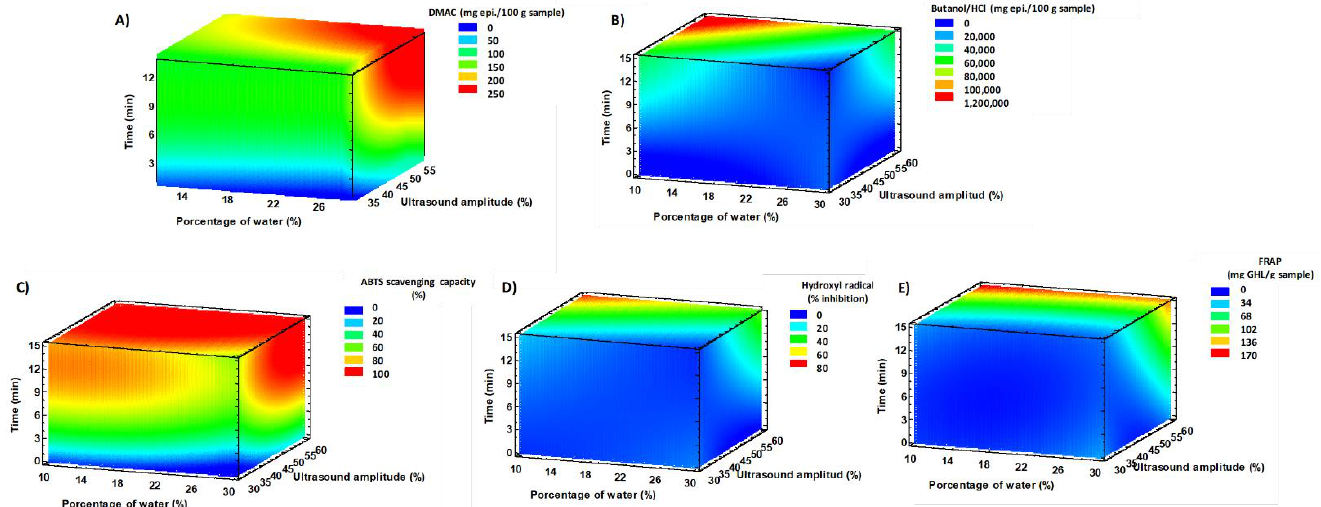
Figure 2. 3-D contour plots showing the effects of the extraction time (min), the ultrasound amplitude (%), and the percentage of water (%) in the NaDES (ChCl:LA, 1:2) on the total PA content (DMAC ( A ) and butanol/HCl ( B ) assays) and total antioxidant capacity (ABTS scavenging capacity ( C ), capacity to inhibit the formation of hydroxyl radicals ( D ), and FRAP ( E ) assays) of extracts obtained from the extraction residue of mangosteen peel.